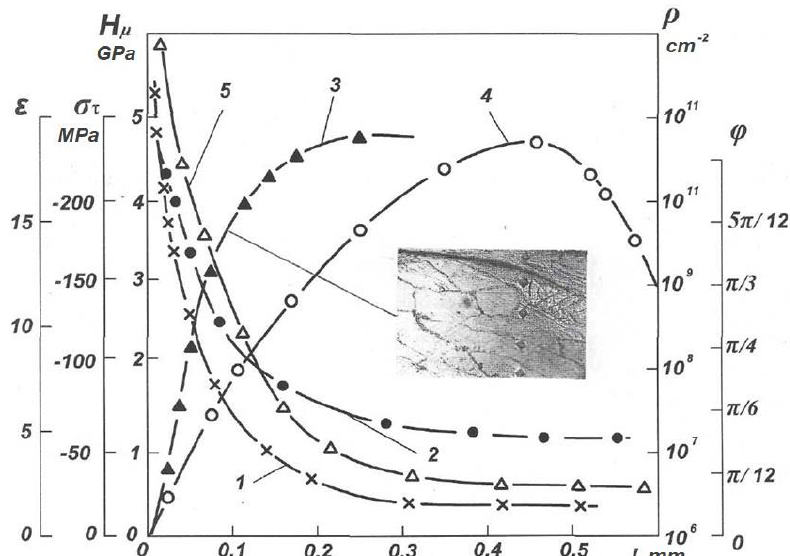
Fig. 1. Distribution of relative deformations of simple shear ε (1), microhardness Hμ (2), tilt angle of texture grains large axes φ (3), compressive tangential residual stresses of the I kind σ τ (4) and dislocation density ρ (5) by thickness of l liner surface layer from steel 10 processed by DB with 20 cycles.